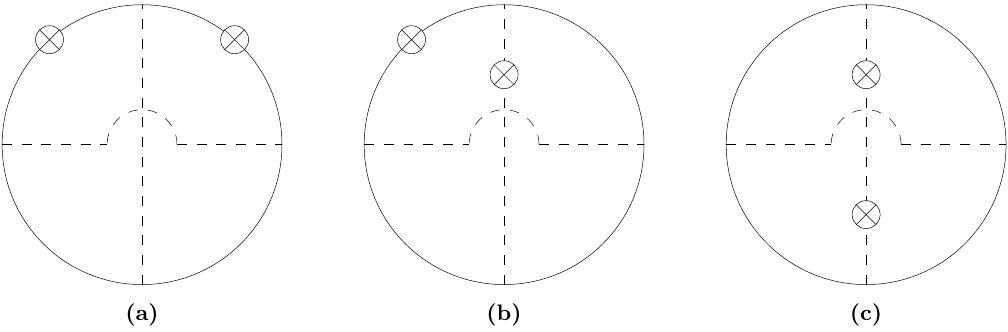
Figure 1. Topologies of the diagrams generating the CP-odd invariant (3.12). Crossed circles represent insertions of the external gauge field. Topology (a) refers to the form in (3.12) written in terms of two fermionic generators, topology (b) to the one in terms of one fermionic and one scalar generator, and topology (c) to the one in terms of two scalar generators. It is intended that each diagram within a given topology should be properly